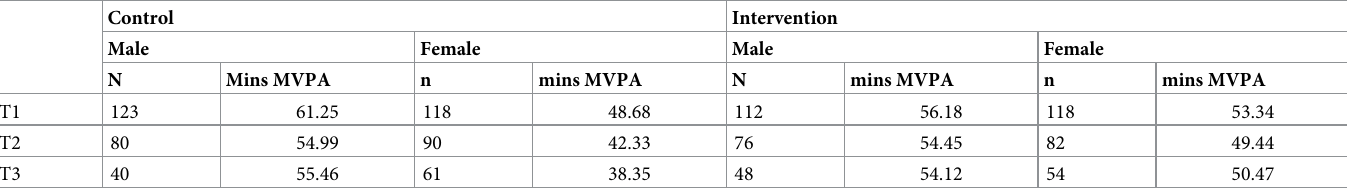
Table 2. Sample size and MVPA (minutes/day) at each time point by gender and intervention condition. Control